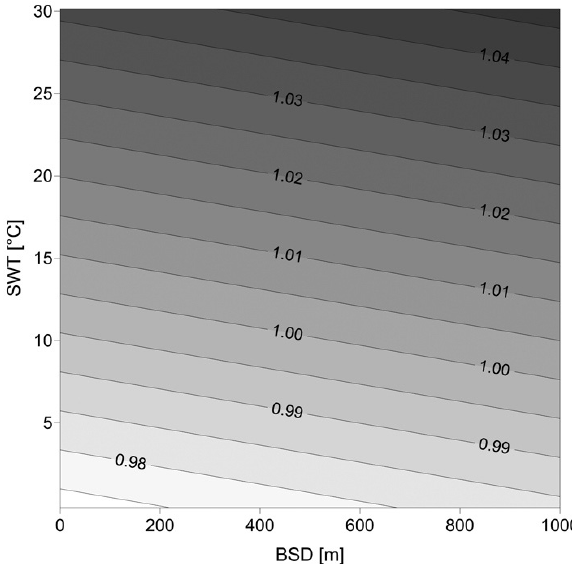
Fig. 1. – Isopleth representation of Sound Compensation Coefficient (SCC) for different sea water temperature (SWT) and sea bottom sea depth (BSD) combinations.